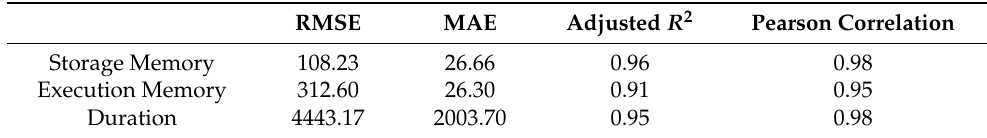
Figure 2. Meta learner regression estimates for the different target variables. These results are detailed in Table 5, which shows the evaluation metrics for each target variable, including the ¯ R 2 score and the Pearson correlation coefficient. In particular, the Mean Absolute Error (MAE) and the Root Mean Square Error (RMSE) for the storage and execution memory represent average errors in megabytes, while for the duration, they represent errors in milliseconds. Table 5. Evaluation metrics on the test